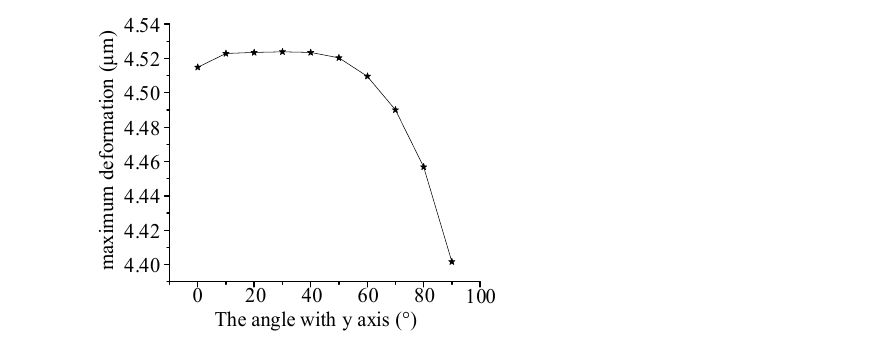
Figure 12. The maximum deformation at different loading positions under turning condition.